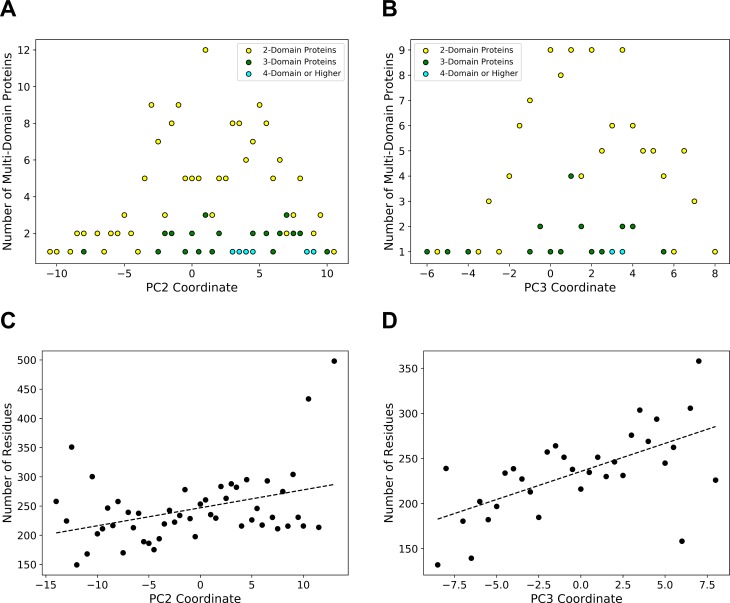
Structure transition along the second and the third axes.(A), the number of multi-domain proteins along the PC2 axis. The same sliding cylinder was used as in Fig 2. Proteins with two domains, three domains, and four or more domains are shown in yellow, green, and cyan, respectively. (B), the number of multi-domain proteins along the PC3 axis. (C), the average protein length along the PC2 axis. The same sliding cylinder was used as in Fig 2. The linear regression shown in the dashed line is (number of residues) = 3.073*(PC2 coordinate) + 246.93. The correlation coefficient is 0.3770. (D), the average protein length along the PC3 axis. The linear regression: (number of residues) = 6.226*(PC3 coordinate) + 235.61. The correlation coefficient is 0.6185.